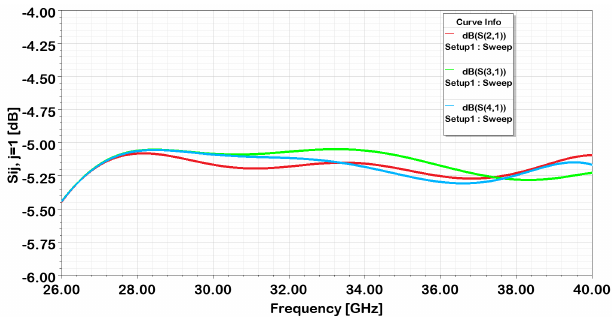
FIGURE 12. Insertion Losses of the system without QWT.